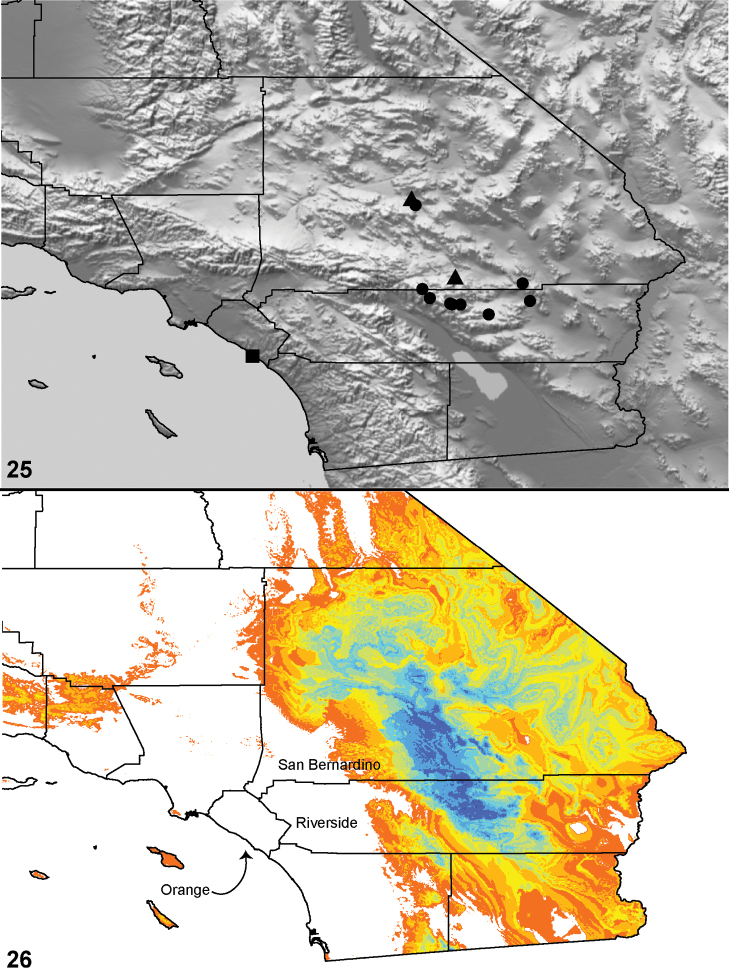
Aptostichus killerdana sp. n. (filled square), Aptostichus serrano sp. n. (filled circles), Aptostichus chemehuevi sp. n. (filled triangles). 25 known distributions 26 predicted distribution of Aptostichus serrano; cooler colors–blue shades–represent areas of high probability of occurrence, warmer colors–yellow and orange shades–represent areas of low probability of occurrence.